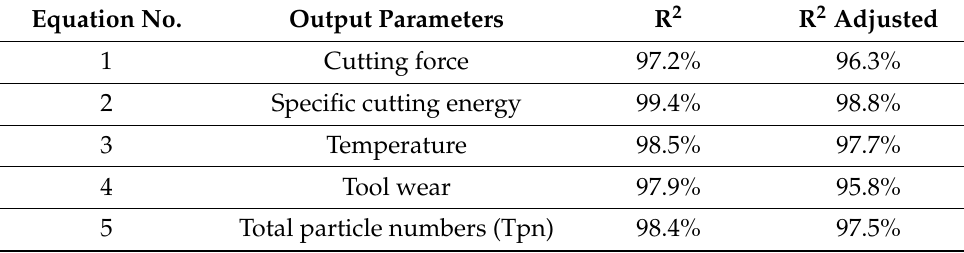
Figure 11. Pareto charts of the standardized effects of ( a ) cutting force Fc, ( b ) specific cutting energy U, ( c ) temperature T, ( d ) tool wear, and ( e ) total particle numbers concentration. A (feed rate), B (speed) AB interaction between feed rate (A) and speed (B). Table 6. Correlation coefficients R 2 and R 2 adjusted for Equations